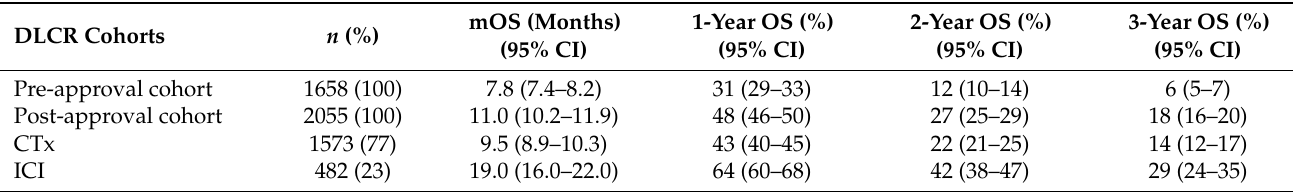
Median overall survival (mOS), 1-, 2-, and 3-year overall survival (OS) rates with 95% confidence interval (CI) before and after the approval of ICI treatment (the pre-approval cohort 1 January 2013–1 August 2014 and the post-approval cohort 1 March 2017–1 October 2018). NSCLC; non-small cell lung cancer; DLCR, Danish Lung Cancer Registry; n , number of patients; CTx, chemotherapy; ICI, immune checkpoint